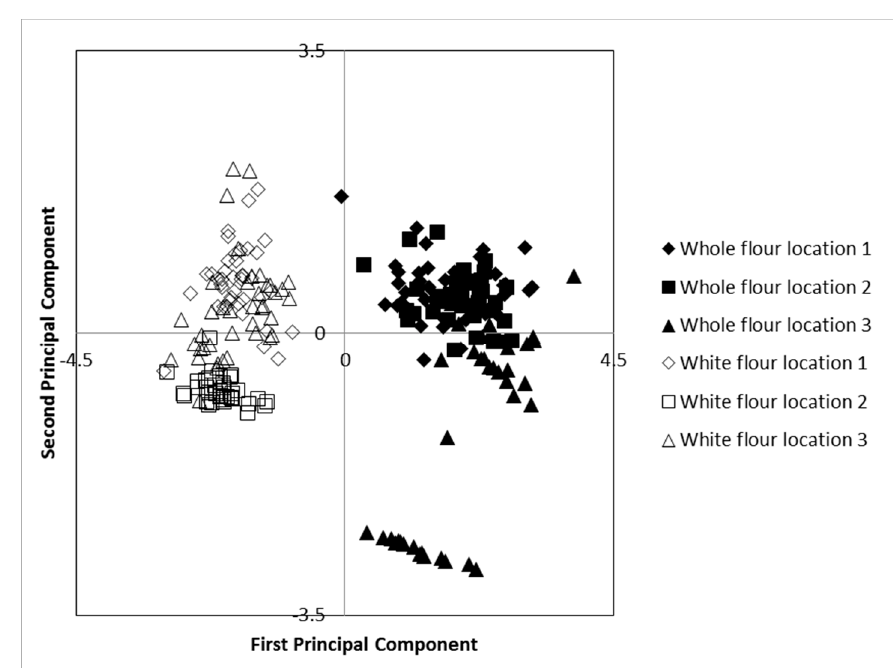
Figure 2. Loading plot from principal component analysis of tocopherols in two flour types of ten varieties grown at three locations in South Africa. Location 1 = Bultfontein, Location 2 = Clarens, Location 3 = Ladybrand. First principal component explained 79.3% of the variation while the second principal component explained 17.4% of the variation.